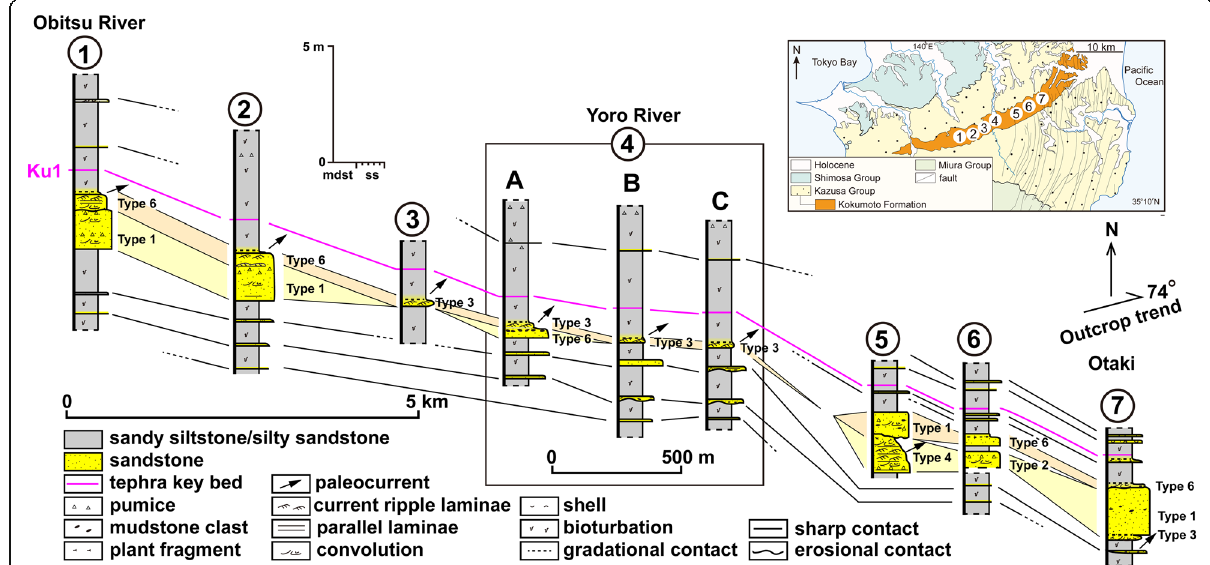
Fig. 10 Downflow changes in thickness and lithofacies types of two sandstone beds below the Ku1 tephra key bed. The inset map shows the locations of the measured sections. See Table 1 for descriptions and interpretations of lithofacies types. The trend of this stratigraphic cross- section (74°) is oblique to the paleocurrent directions (47 – 70°)